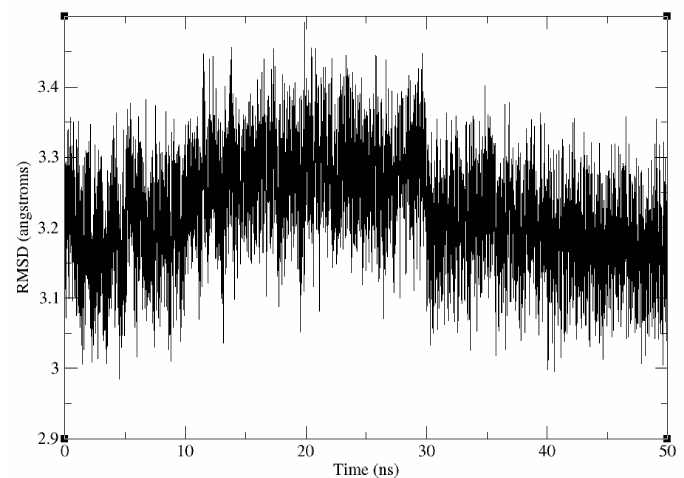
Figure 7. Backbone RMSD of the truncated SARS-CoV-2 S RBD and ACE2 complex relative to the truncated part of the experimental crystal structure of the full complex, along the 50 ns production